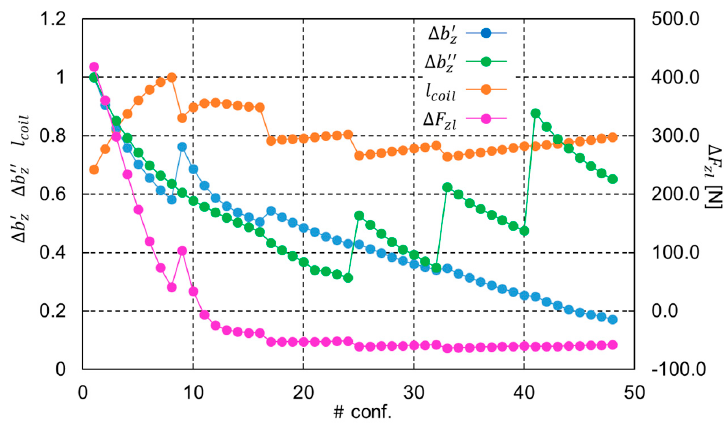
Figure 11. Results of the parametric analysis on the pole shoe shape of the AHMB lower side.